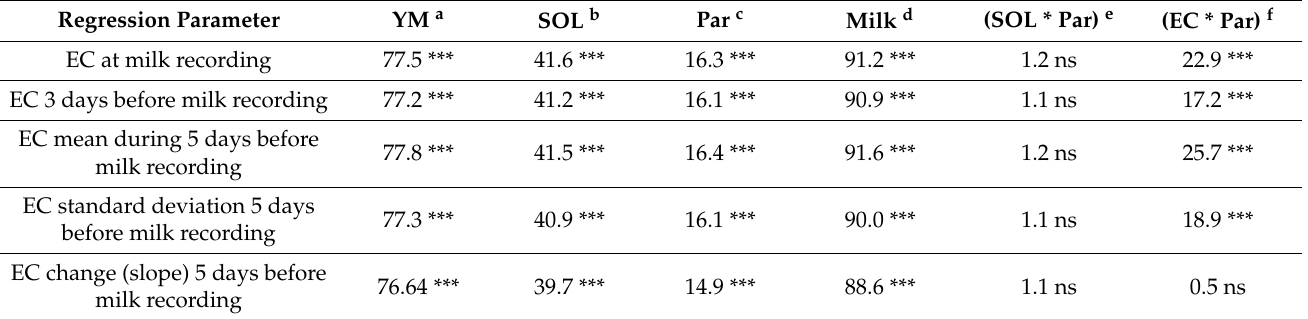
Table 4. F-value and significance of fixed effects included in the analysis for somatic cell score and milk conductivity.